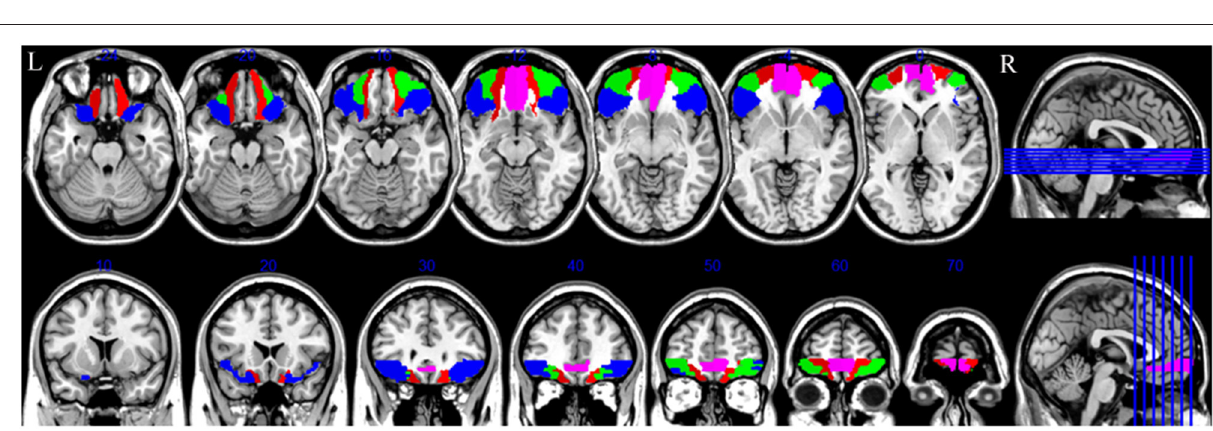
enrolled, including those assigned to the NC group ( n = 25, 67.10